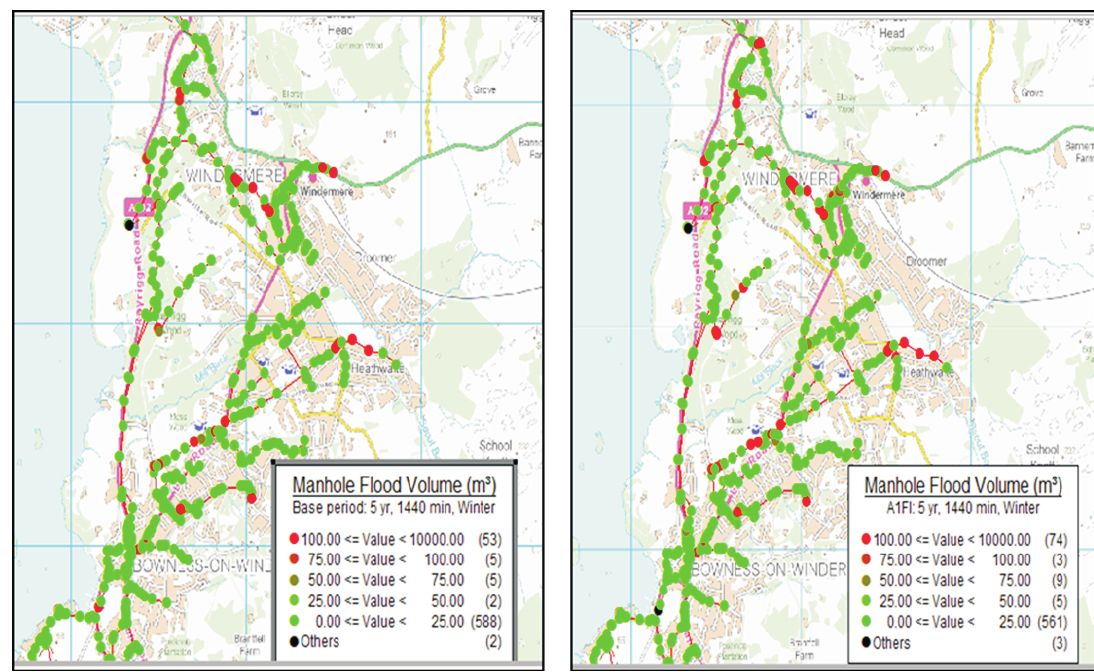
Figure 4: Location of flooding manholes in part of Windermere catchment in the present (left) and future 2080s in winter under scenario A1FI (right); where the number of flooding manholes is 94 and 120, respectively.